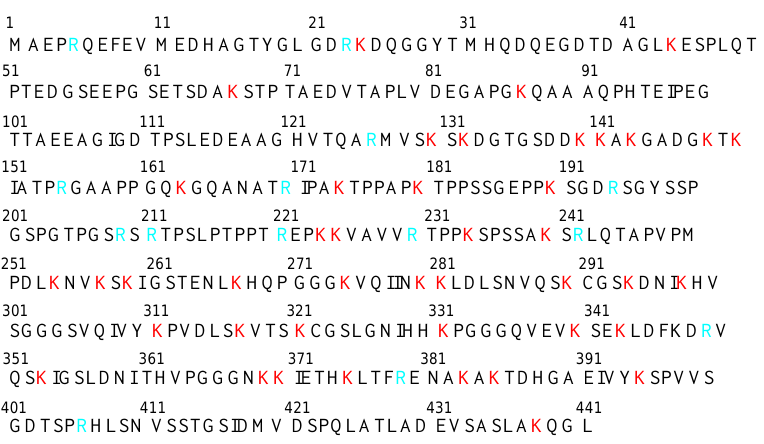
Figure 6. Amino acid sequence of human tau441 (2N4R). Lysines are shown in red and arginines are shown in light blue.